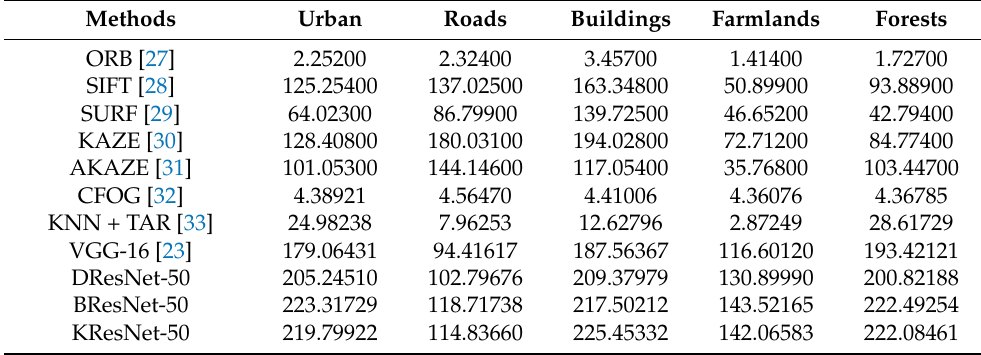
Table 2. Time complexity comparison of different registration algorithms